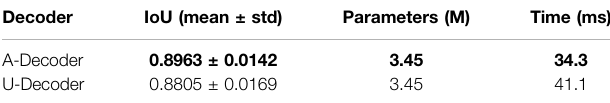
TABLE 4 | The results of ablation study for